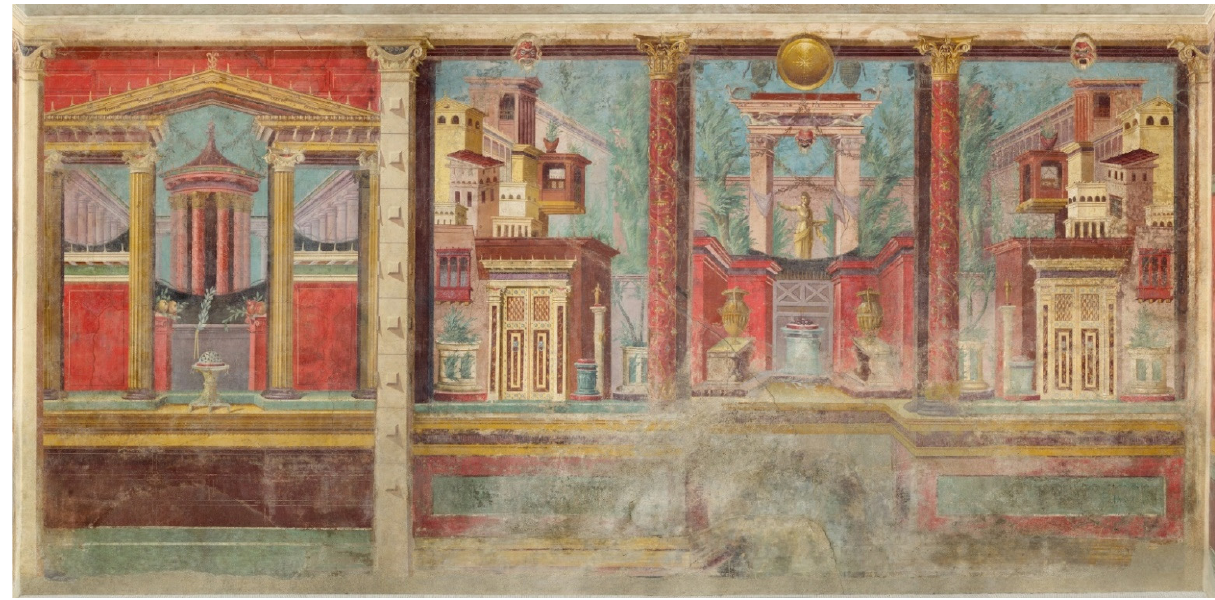
Figure 20. Cubiculum M, Villa of Publius Fannius Synistor, Boscoreale, view of west wall, c. 50–40 BCE. Roman. Fresco; room dimensions: 8 ft. 8 1/2 in. × 10 ft. 11 1/2 in. × 19 ft. 1 7/8 in. (265.4 × 334 × × 10 ft. 11 1/2 in. × 19 ft. 1 7/8 in. (265.4 583.9 cm). Metropolitan Museum of Art, Rogers Fund, 03.14.13a–g. Digital image available under BCE. Roman. Fresco; room dimensions: 8 ft. 8 1/2 in.